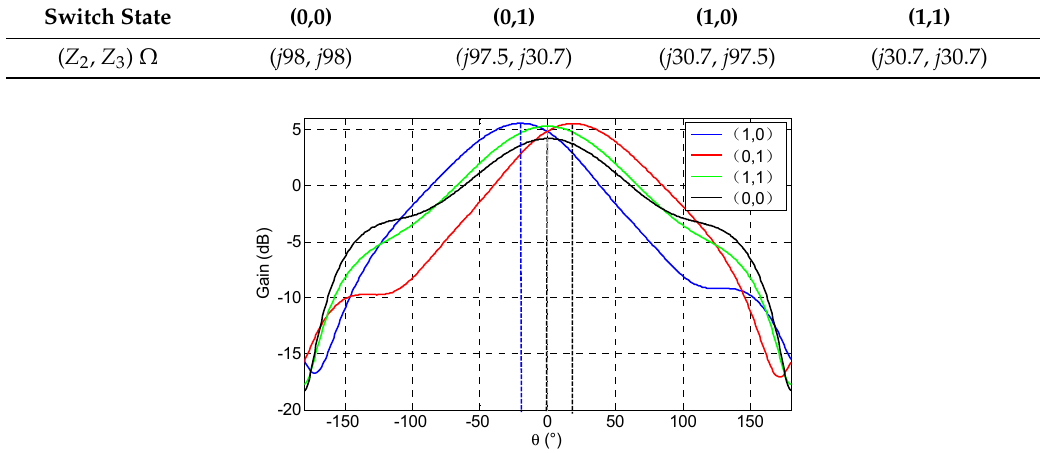
Figure 5. The simulated gain results of the proposed RF MEMS pattern reconfigurable antenna.